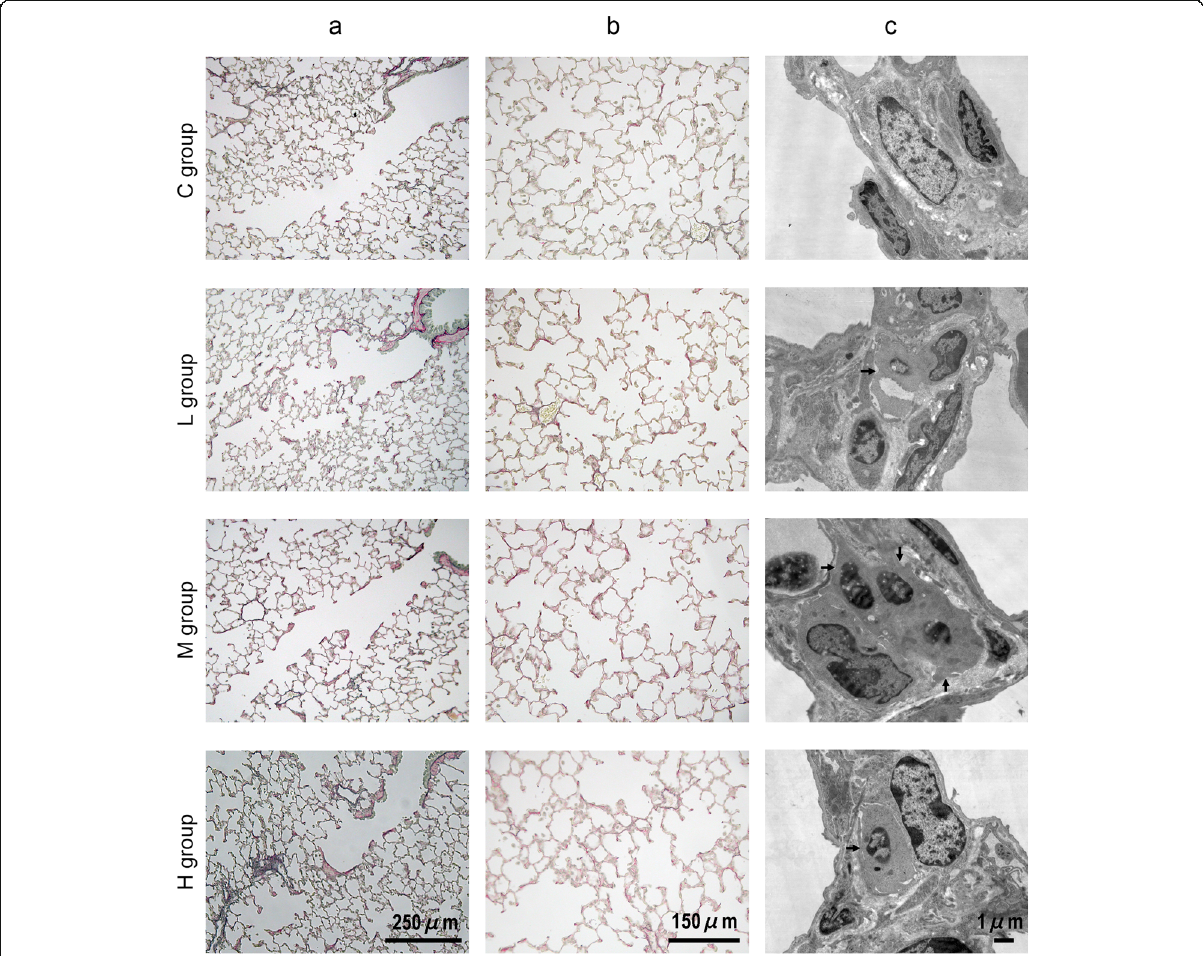
Fig. 3 Effect of HONO exposure on the respiratory tract observed under light microscopy using Elastica van Gieson and transmission electron microscopy (TEM). a The terminal bronchiole and alveolar duct regions. b The alveolar regions. c Interstitium of alveolar duct regions under TEM. Arrows in the L, M, and H groups indicate smooth muscle cells that have abundant mitochondria and intermediate microfilaments